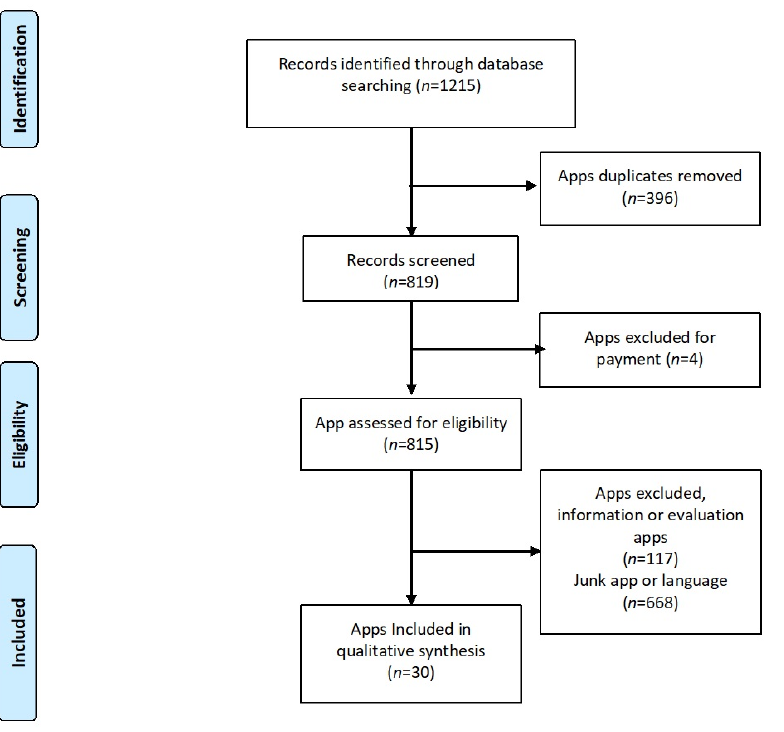
Figure 1. PRISMA Flow diagram for selected apps.